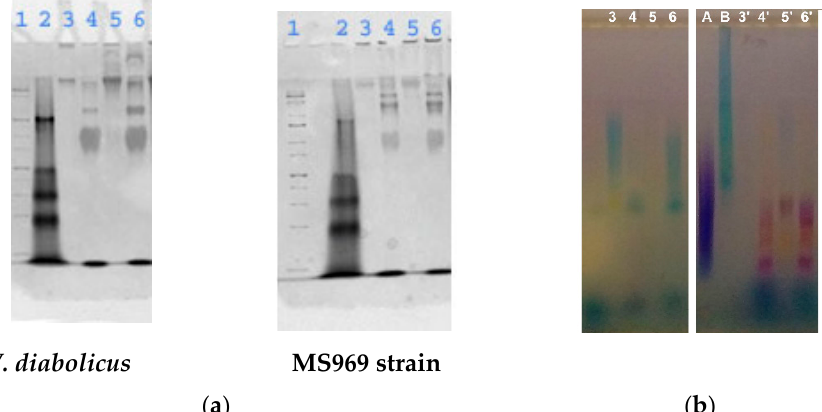
Figure 6. Electrophoretic analysis of extracts. Gels were stained with Stains All. ( a ) PAGE of V. diabolicus extracts and MS969 strain extracts. 1: O’GeneRuler 1 kb Plus DNA Ladder, 2: Prestained Protein MW Marker (Thermo Scientific, 26612), 3: SnB, 4: AB, 5: SnP, and 6: AP. ( b ) Agarose gel of V. diabolicus (3: SnB, 4: AB, 5: SnP, 6: AP) and MS969 extracts (3 ′ : SnB, 4 ′ : AB, 5 ′ : SnP, 6 ′ : AP). A: GY785 EPS and B: HE800 EPS were used as standards [67,68].